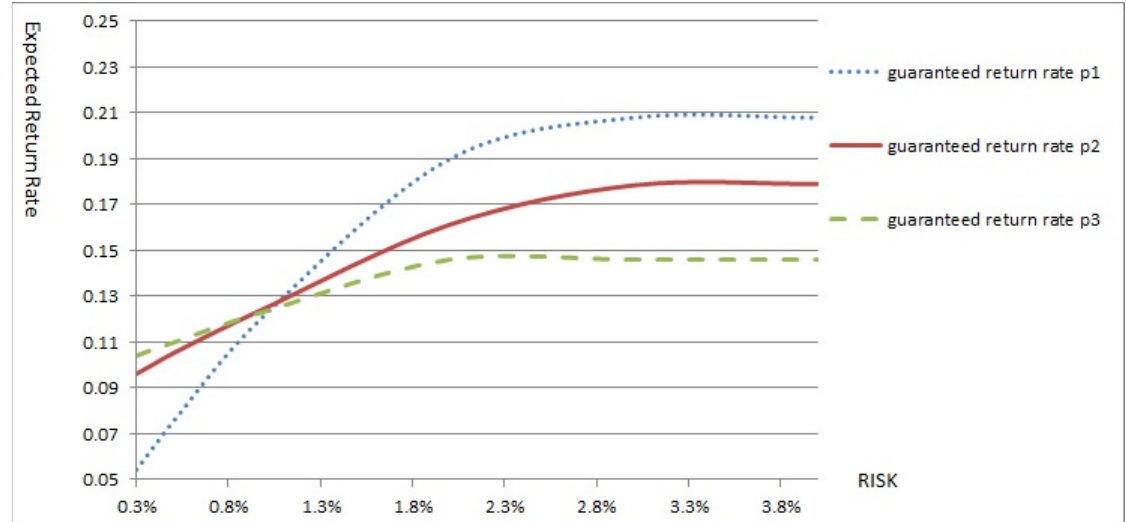
Figure 2. The comparisons between different guaranteed return rates.